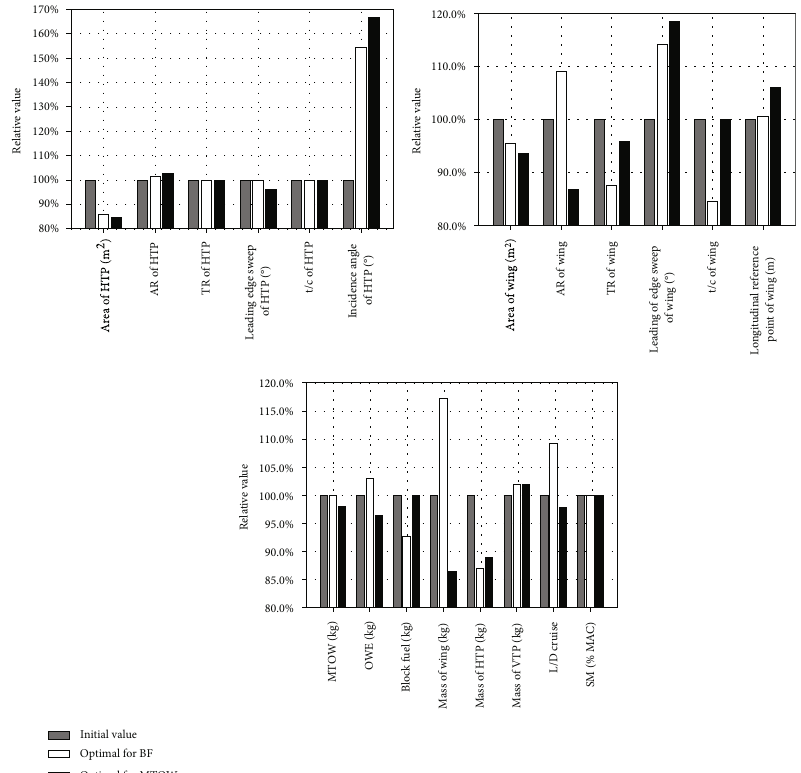
Figure 2: Relative changes of design variables, design constraints, and design objectives for HTP-wing optimization.